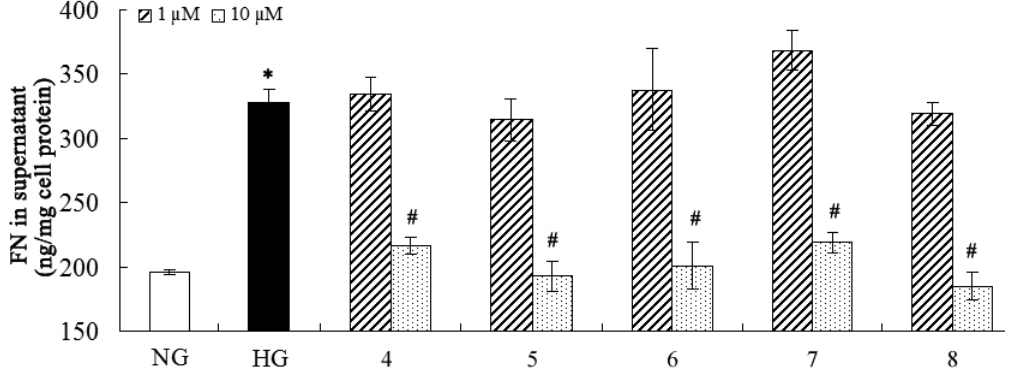
Figure 3. Inhibitory effect of the compounds on fibronectin. * p < 0.05 vs . normal glucose; # p < 0.05 vs. high